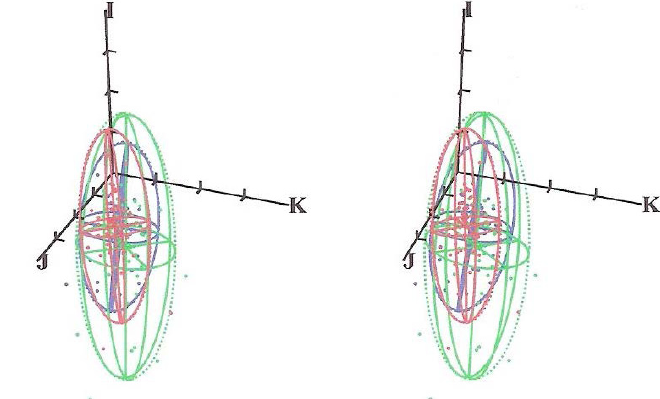
Figure 3: Stereo-pair scatter plot of fifty measurements of re- fractive state taken from subject 2. The origin of the axes is at −1 I D.